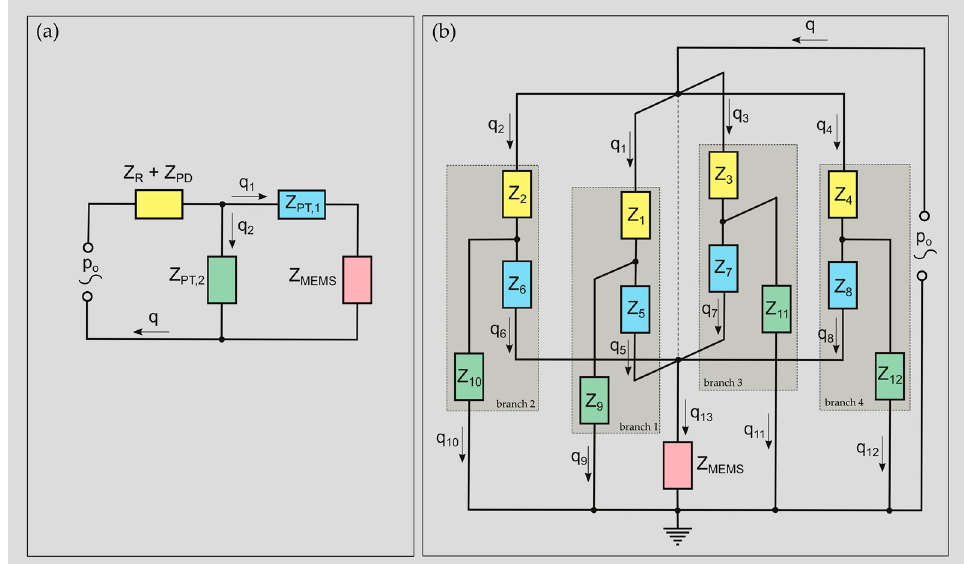
Figure 4. ( a ) Simplified equivalent electrical circuit representing the lumped element model (LEM) of an MEMS microphone (MEMS MIC) sealed with one protective diaphragm (PD) and ( b ) with up to four PDs. Z 1 … Z 4 : acoustic impedance of the PD and its interaction with the surroundings; Z 5 … Z 8 : dissipation and inertia caused by the pneumatic tubing system between the PD and MEMS diaphragm; Z 9 … Z 12 : acoustic stiffness of the pneumatic tubing system between the PD and MEMS diaphragm; Z MEMS : acoustic impedance of the (unsealed) MEMS MIC without considering the inlet channel (pressure port).